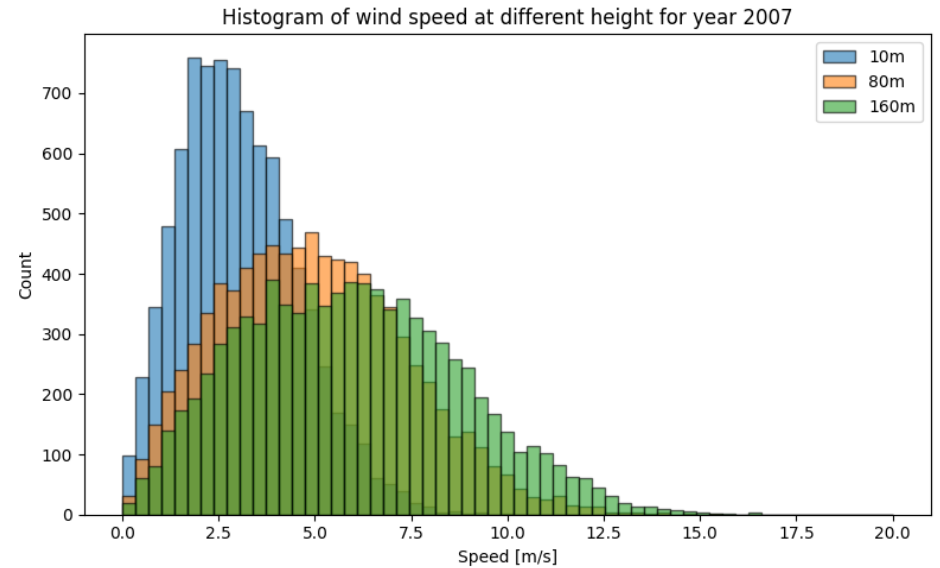
Figure 3. Histogram of wind speed at different heights for year